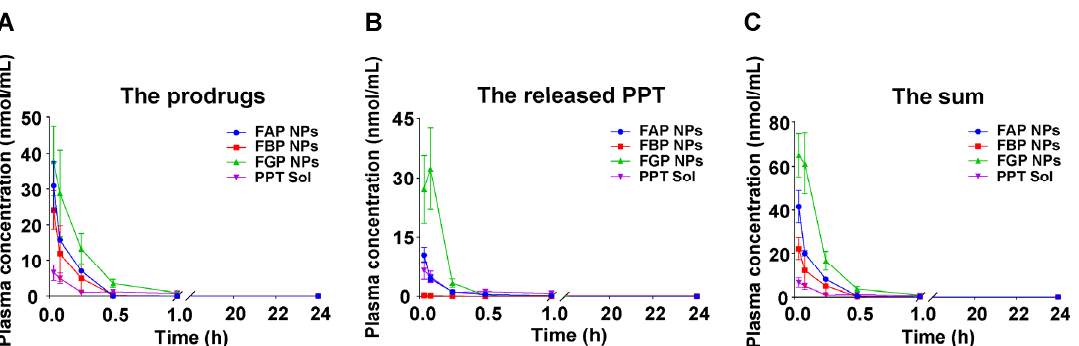
Figure 5. Pharmacokinetic profiles of prodrug NPs ( n = 6). Molar concentration − time curves of ( A ) the prodrugs, ( B ) the released PPT and ( C ) their sum.